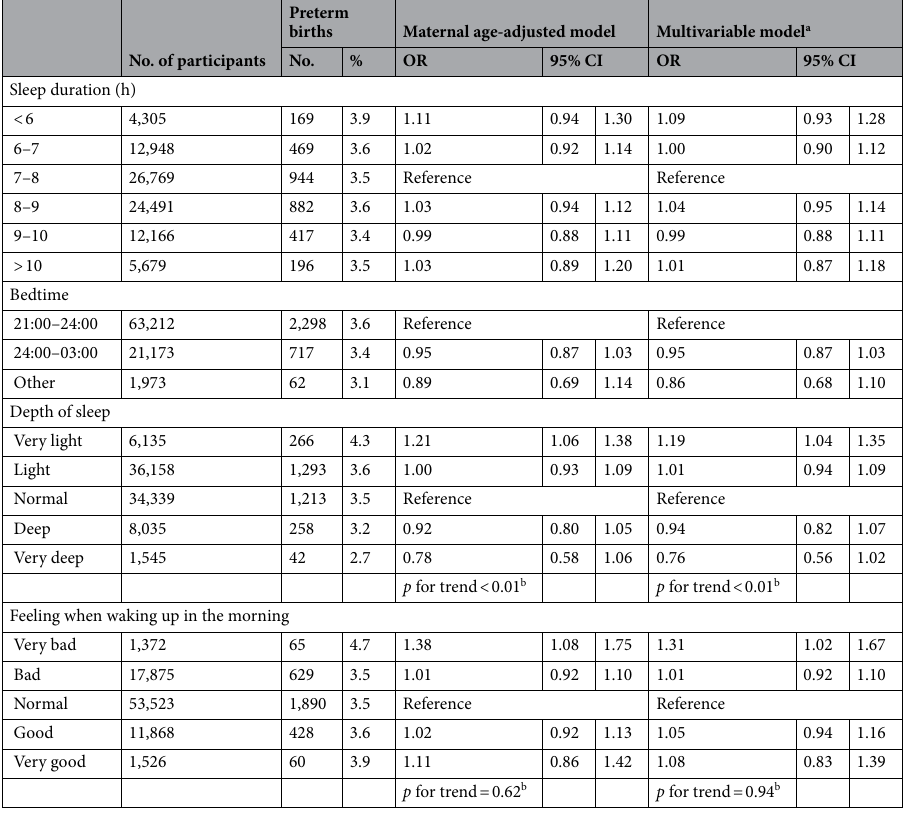
Table 3. Association between sleep during pregnancy and late preterm birth in the Japan Environment and Children’s Study (2011–2014). CI, confidence interval; RR, relative risk. a Adjusted for maternal age at delivery, smoking habits, alcohol consumption, pre-pregnancy body mass index, parity, current history of diabetes or gestational diabetes, hypertensive disorders in pregnancy and intrauterine infection, history of preterm birth, and infertility treatment. b Linear trend in the association was tested by assignment of ordinal variables for the five